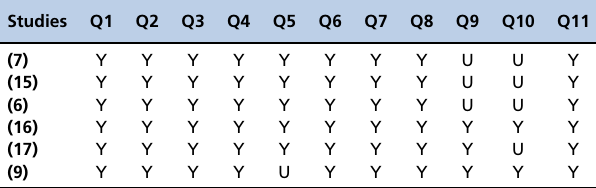
Table 2 - Results of the critical assessment of the included studies (Cohort) using the Joanna Briggs Institute approach.